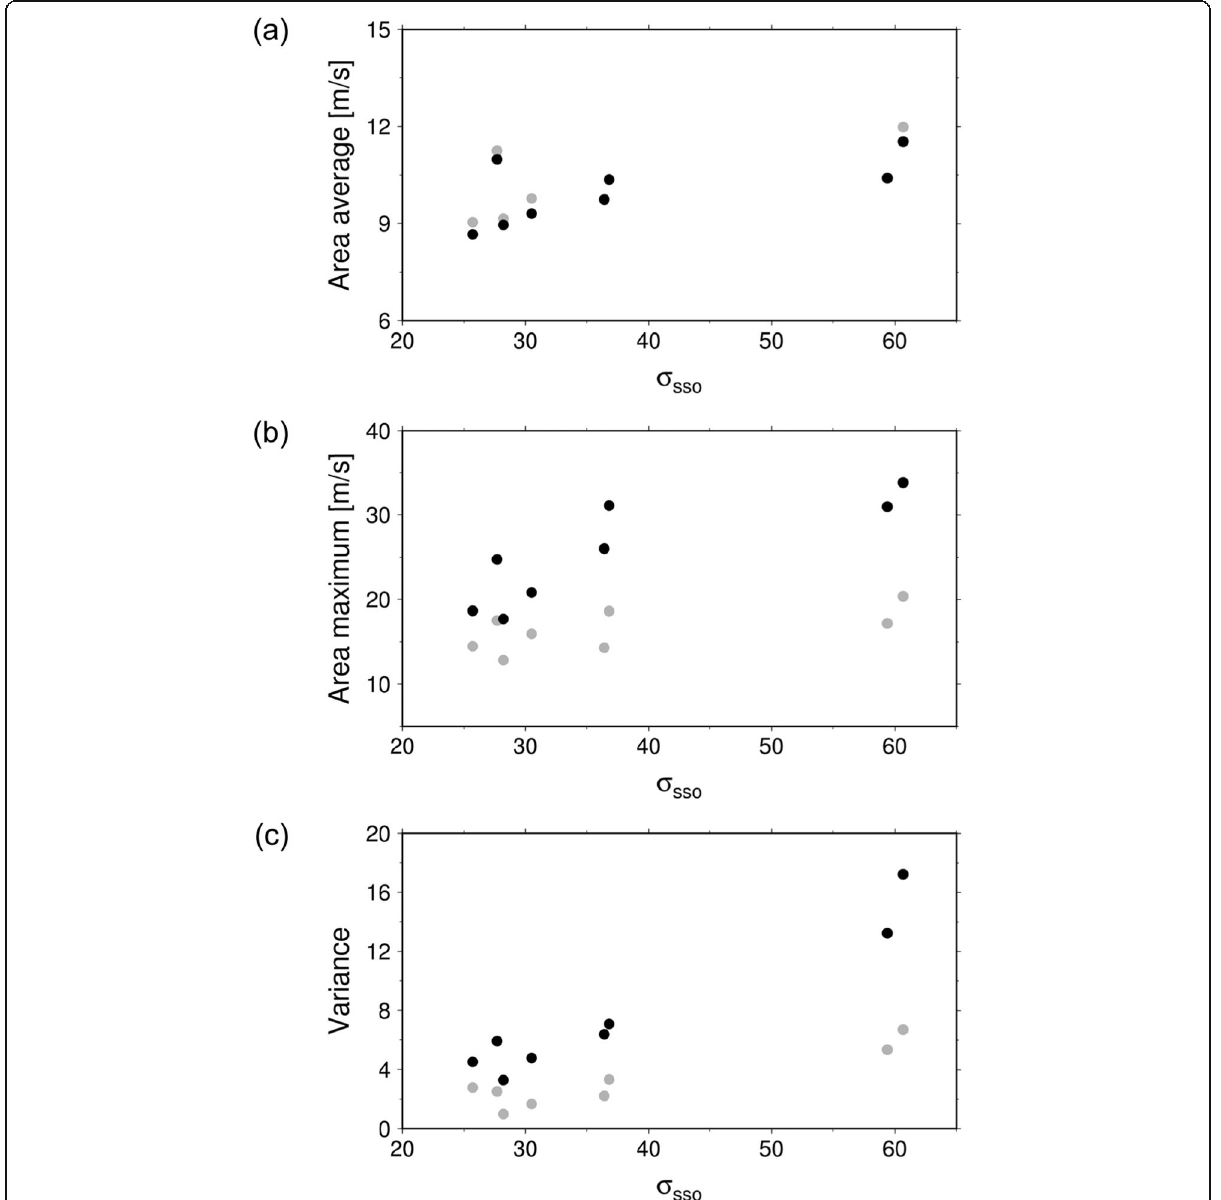
Fig. 9 The relationships between the subgrid-scale orography and the wind representations. The relationships of the area-mean standard deviation of terrain heights within each D04 area with a the area-mean wind speed, b the area-maximum wind speed, and c the spatial variance of wind speed in the same D04 area. Black and gray points indicate the results of the 200 m grid case and the 1 km grid case,